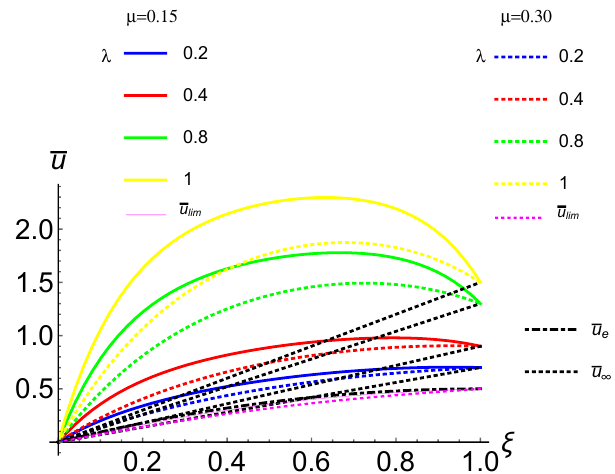
Figure 8. CF nano-rod with a uniformly distributed axial load. Plot of the non-dimensional axial displacement ¯ u , limit non-dimensional axial displacement ¯ u ∞ (black dotted line) and local non-dimensional axial displacement ¯ u e (black dot dashed line) vs. the nano-rod non-dimensional length ξ in terms of the nonlocal non-dimensional parameter λ in the set { 0.2,0.4,0.8,1.0 } and gradient non-dimensional parameter µ in the set { 0.15,0.30 }